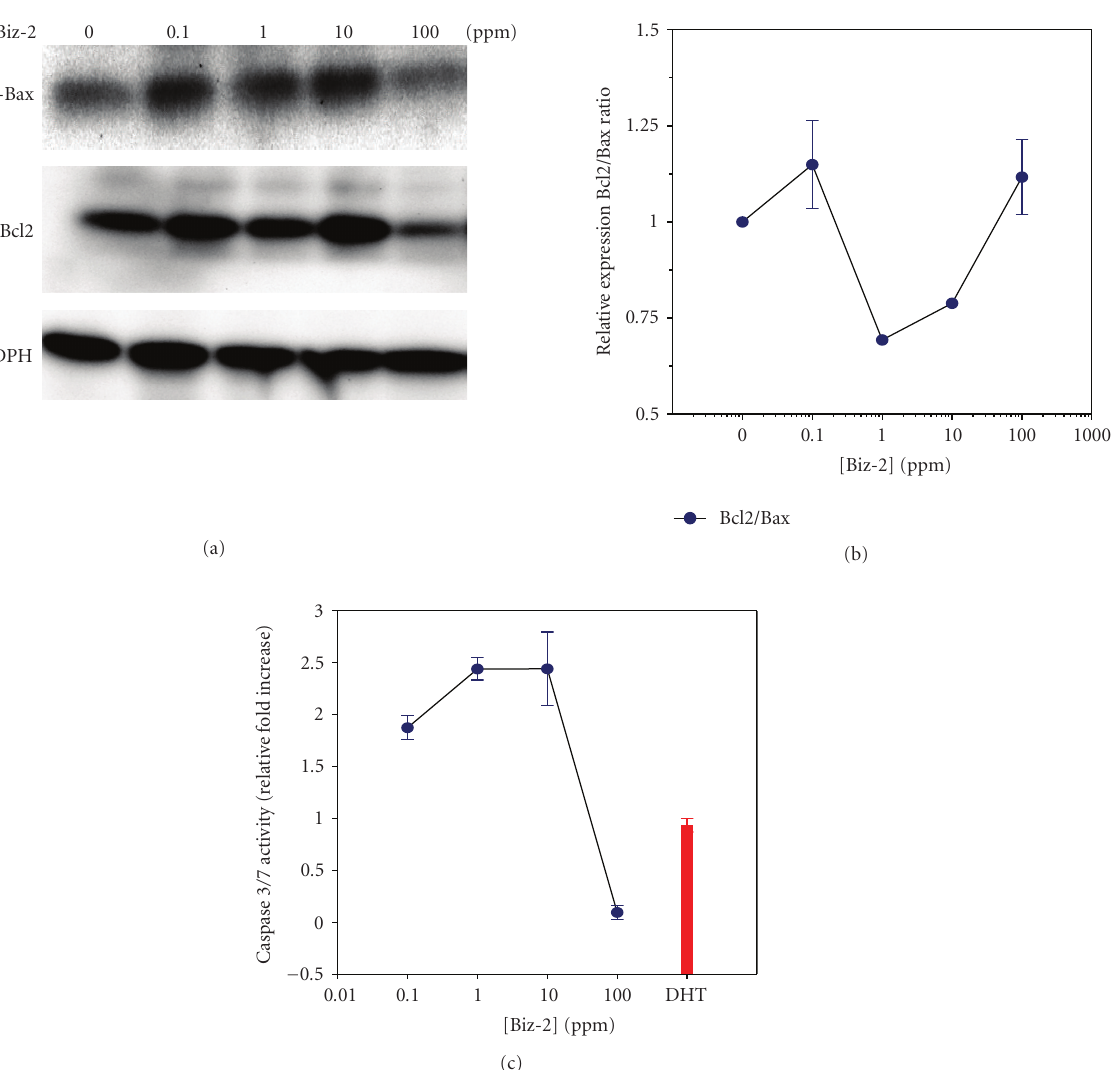
Figure 7: Modulation of apoptotic protein levels in the presence of Biz-2. LNCaP cells were grown in a serum-free medium in the presence of increasing concentrations of Biz-2 for 24 hours. Whole-cell extracts were isolated with RIPA bu ff er, and 30 μ g of protein extract were analyzed by immunoblotting for Bcl-2, Bax, AR, and GDPH expression. (a) Immunoblot of Biz-2-induced proteins. (b) Ratio of Bcl2/Bax expression. (c) Biz-2 induces increase in Caspase 3/7